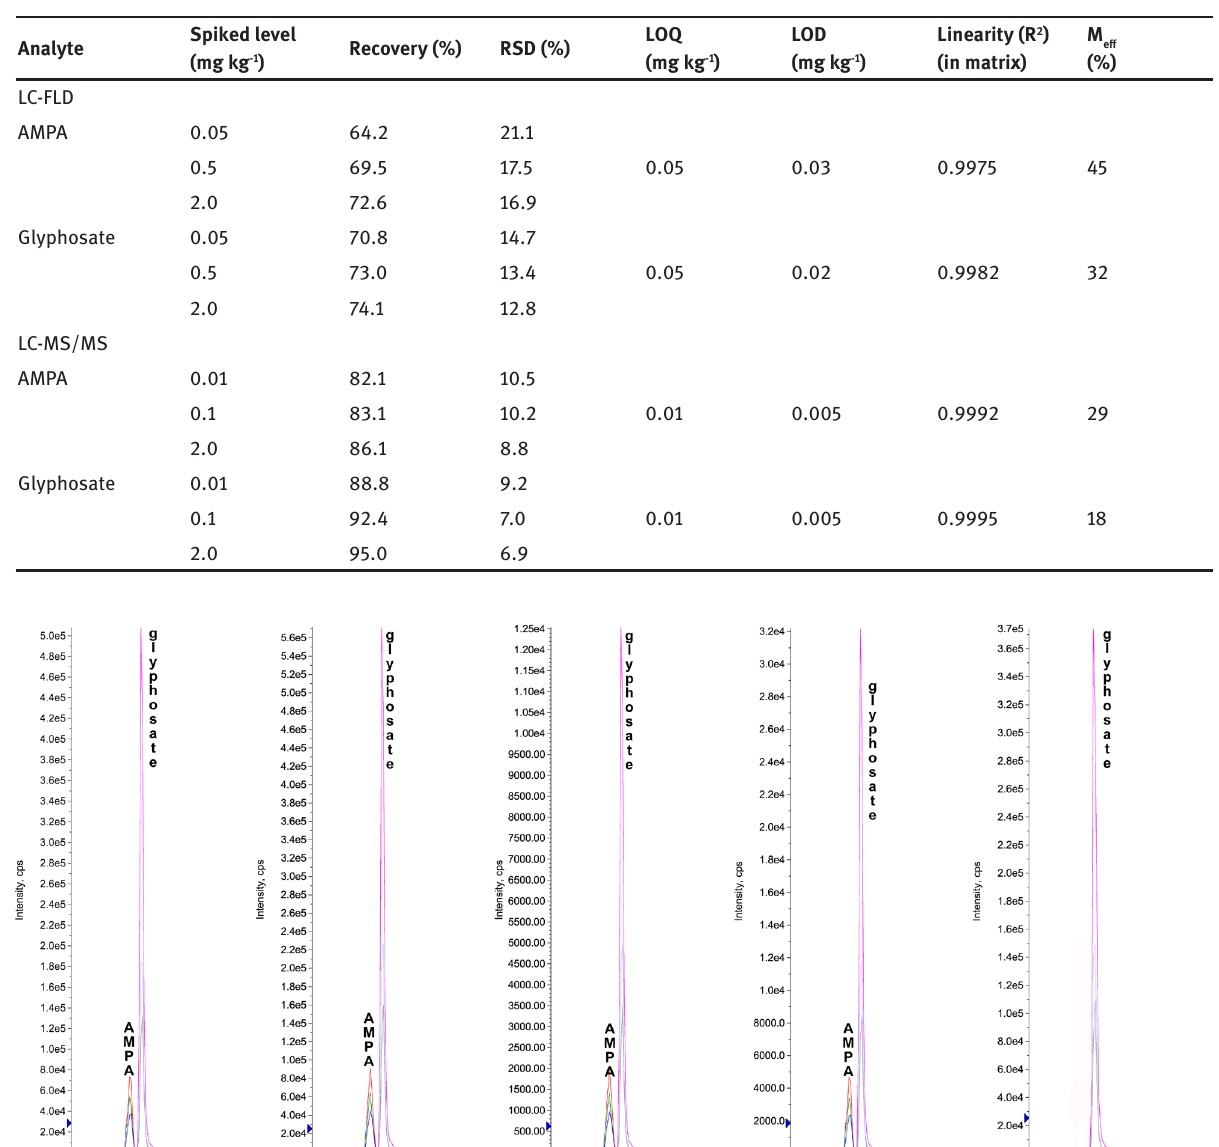
Table 3: Validation results.